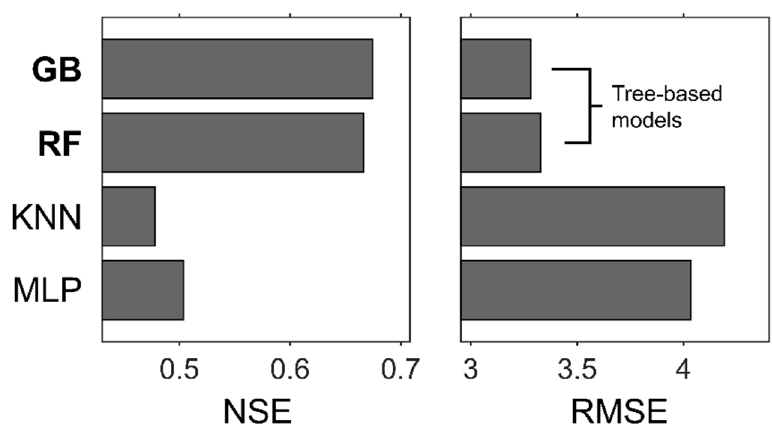
Figure 3. Comparison of machine learning model performance. Two tree-based models, GB and RF, showed higher performance than the others. KNN, k -nearest neighbors; MLP, multilayer perceptron; NSE, Nash–Sutcliffe model efficiency; RMSE, root mean-squared error.